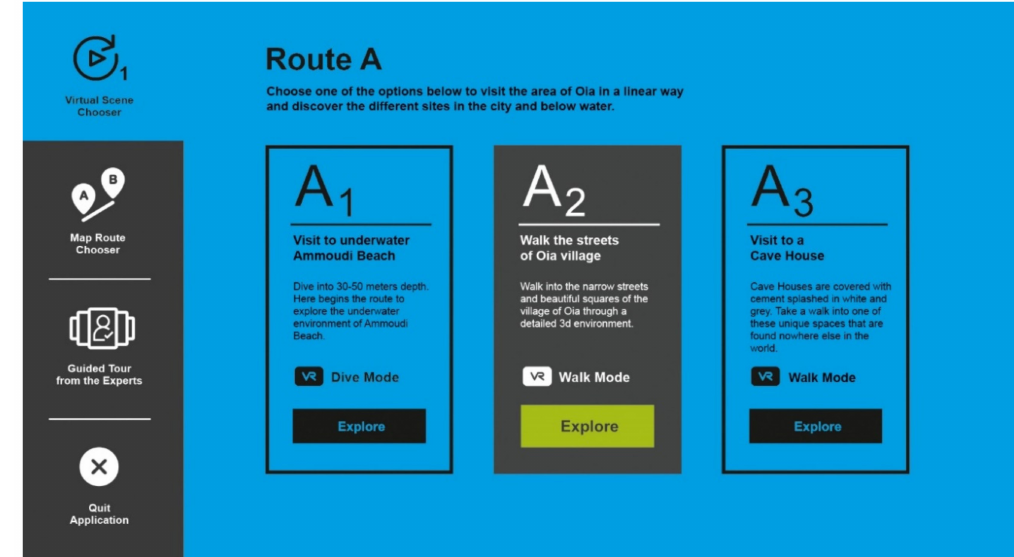
Figure 13. User interface of Map Route Chooser (screenshot): The user can choose between di ff erent routes through a map.